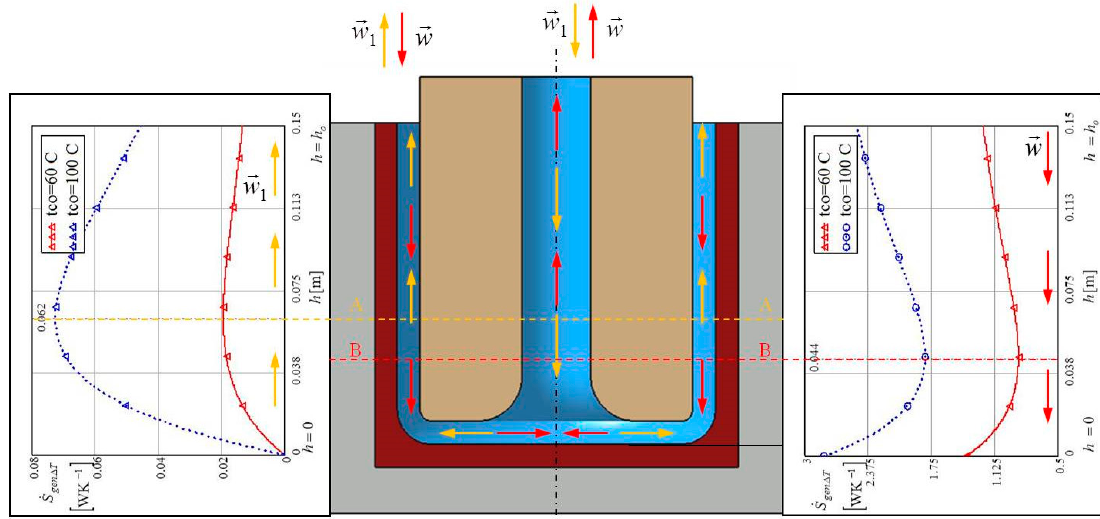
Figure 10. The comparison of the thermal entropy of the individual influence the vertical annular channel in case central ( left ) and peripheral ( right ) impinging jet.